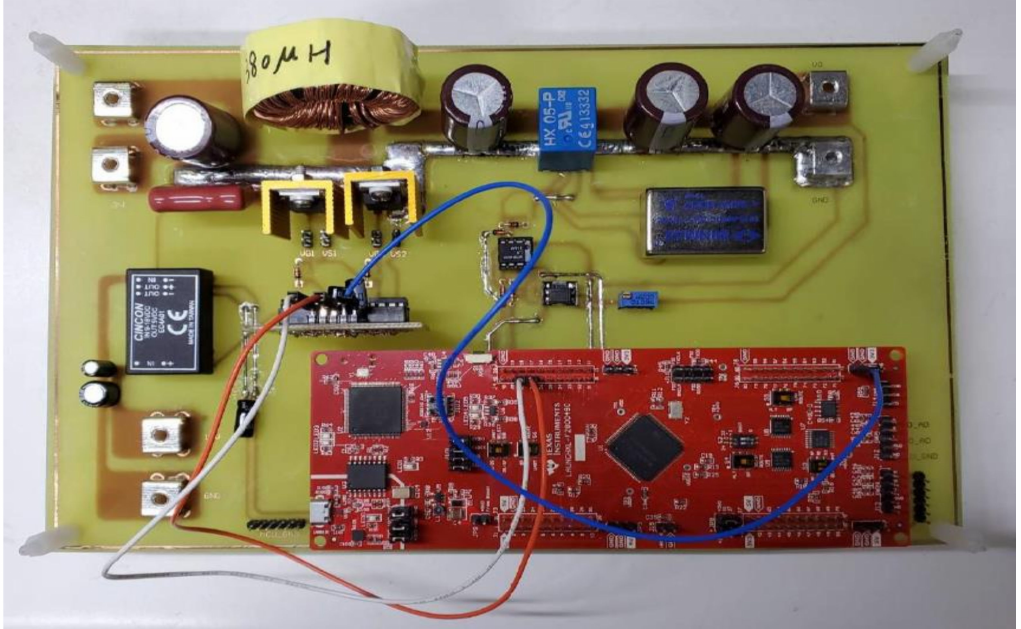
Figure 10. Picture of the proposed MPC